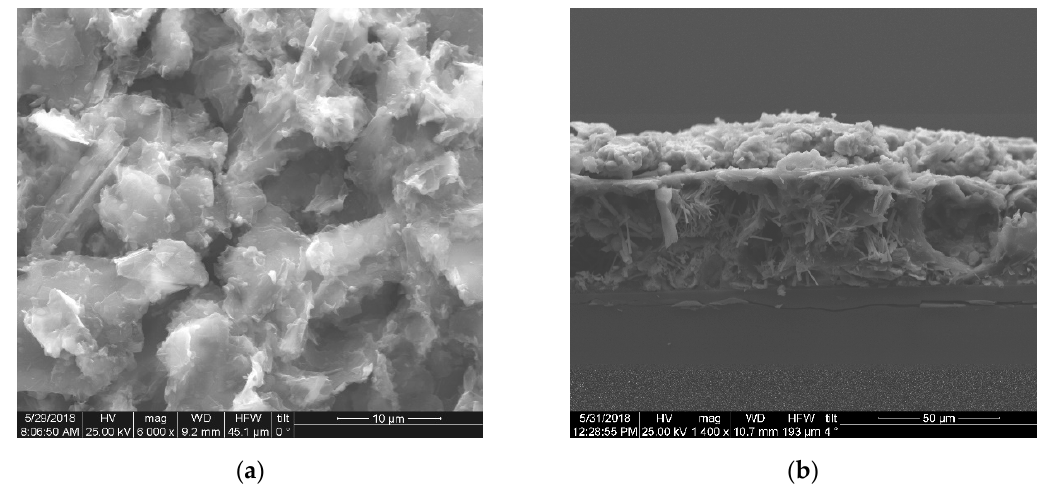
Figure 1. SEM images of the graphite/SiO 2 working electrode from ( a ) top view and ( b ) a cross section.